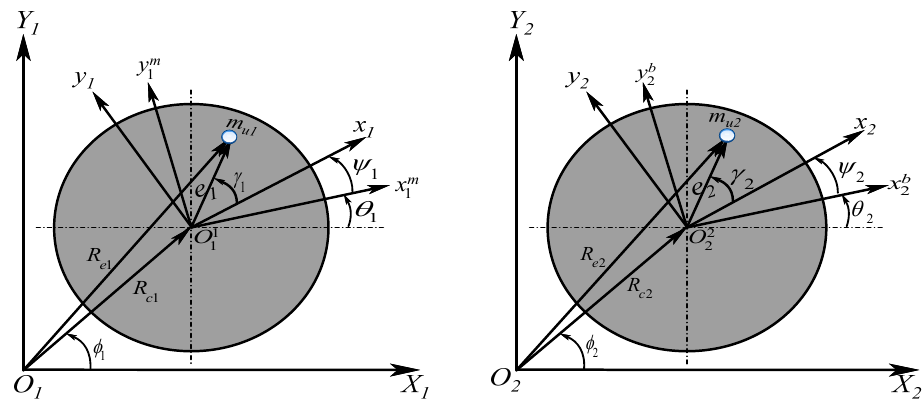
Figure 2. Deformed configuration of the shaft attached with discs 1 and 2, respectively.